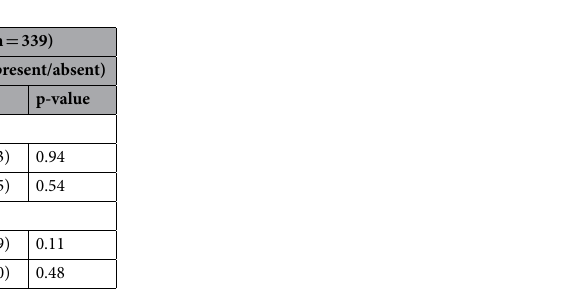
Table 2. Relationship between sugary food sub-groups consumption and early childhood